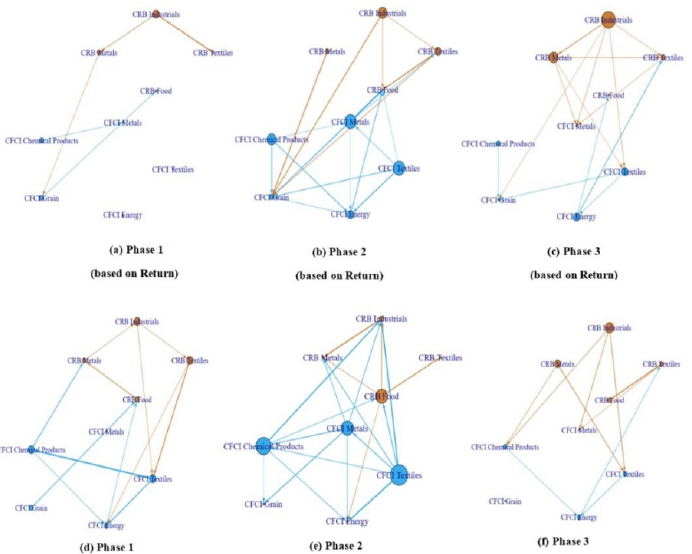
Figure 6. Net volatility spillover network diagrams for the three periods. Notes: (1) The larger the node, the greater the “out-degree” of the variety in risk contagion; (2) the orange line represents that the international variety is the risk exporter, and the blue line represents that the Chinese variety is the risk exporter; (3) return’s net volatility spillover network is based on the part where the net volatility spillover index is greater than 2; the net volatility spillover network diagram of VaR is based on the part where the net volatility spillover index is greater than 5; (4) Panels ( a )–( c ) are the network diagrams based on Return while ( d )–( f ) are based on VaR.